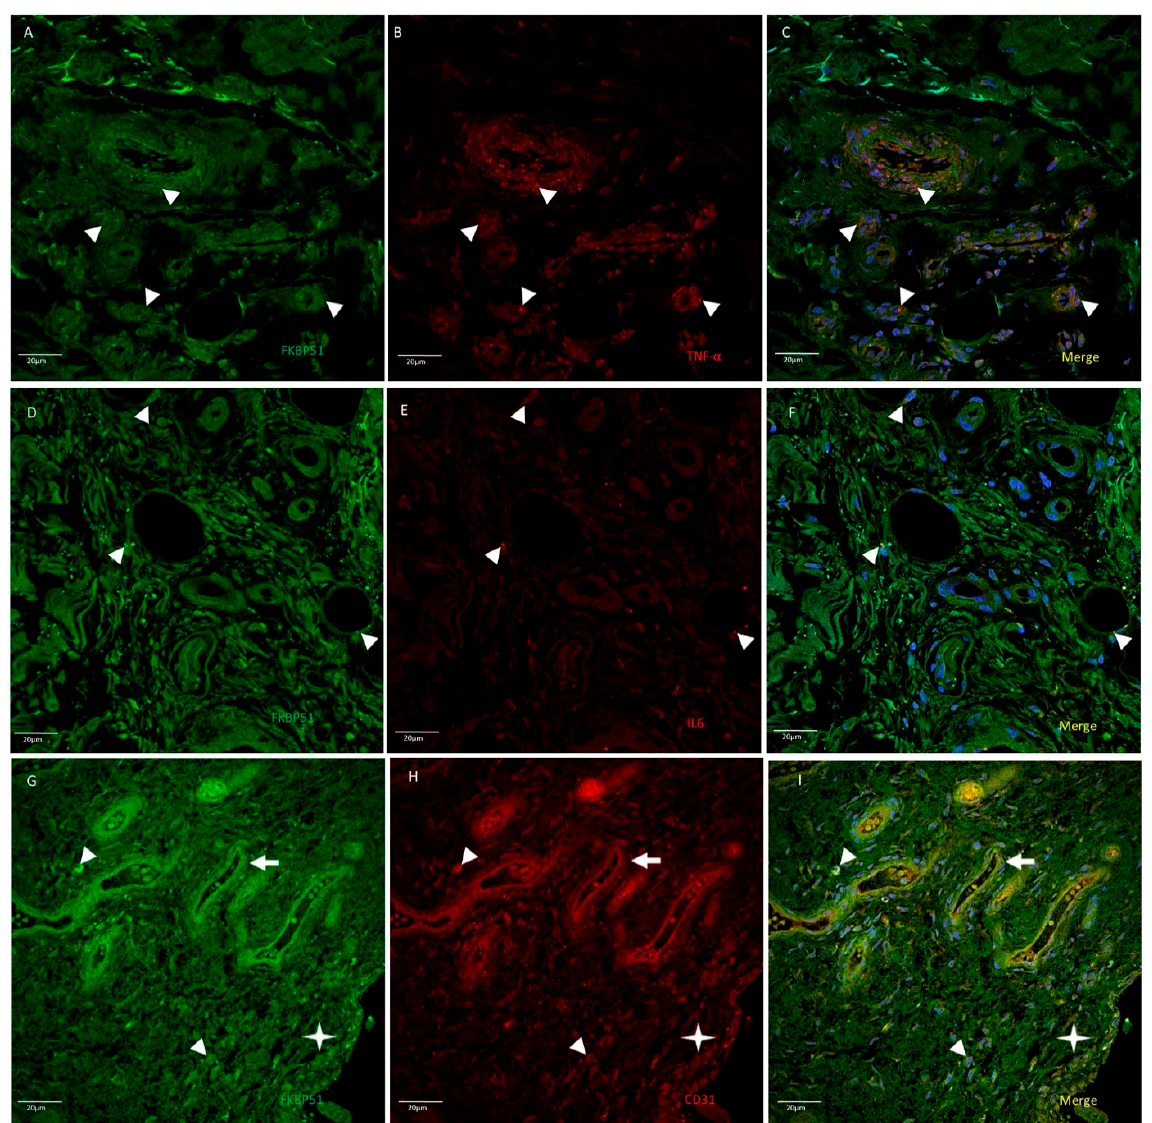
Figure 7. Double immunolabelling for FKBP51 and inflammatory markers TNF- α (panels A – C ) and IL-6 (panels D – F ) and endothelial and white cells marker CD31 (panels G – I ) in synovial tissue sections from a patient with knee OA (grade IV). Merges also contain DAPI staining. Double immunostaining of FKBP51/TNF- α and FKBP51/IL-6 (arrowheads). Panels G – I : FKBP51+/CD31+ staining in some cells (arrowheads), arrows point to a vessel and the star is placed in the proliferated synovial membrane, showing FKBP51+/CD31+ cells.